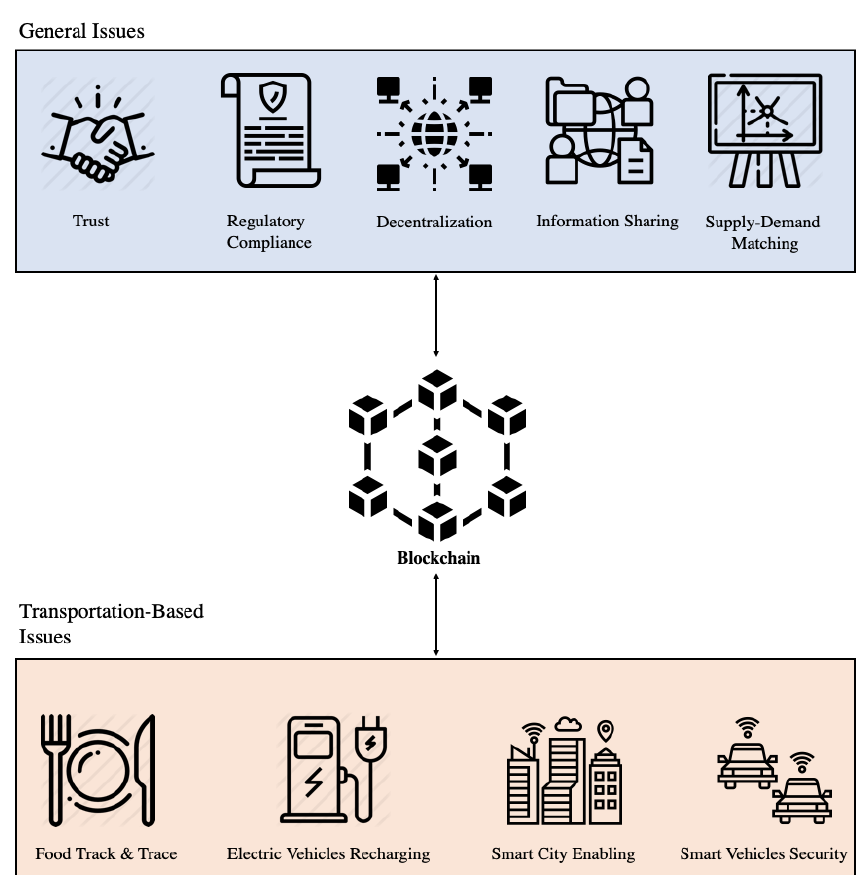
Figure 6. General and transportation-based emerging issues in the application of blockchain